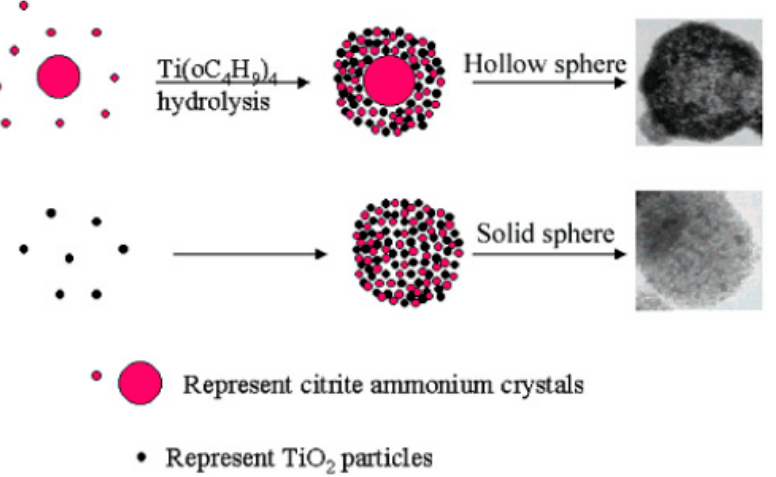
Figure 2. Scheme of mesoporous hollow and solid spheres formation. Reprinted with permission from [50]. Copyright 2005, American Chemistry Society.